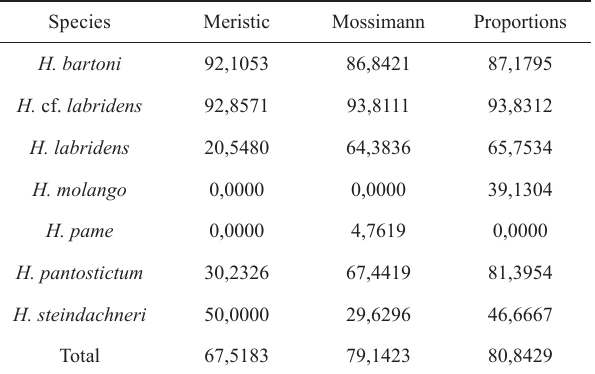
Distribution. Laguna de la Media Luna and río Verde.